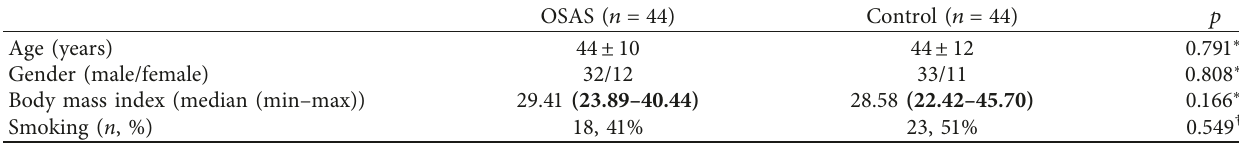
Table 1: Demographic and some clinical characteristics of the groups.